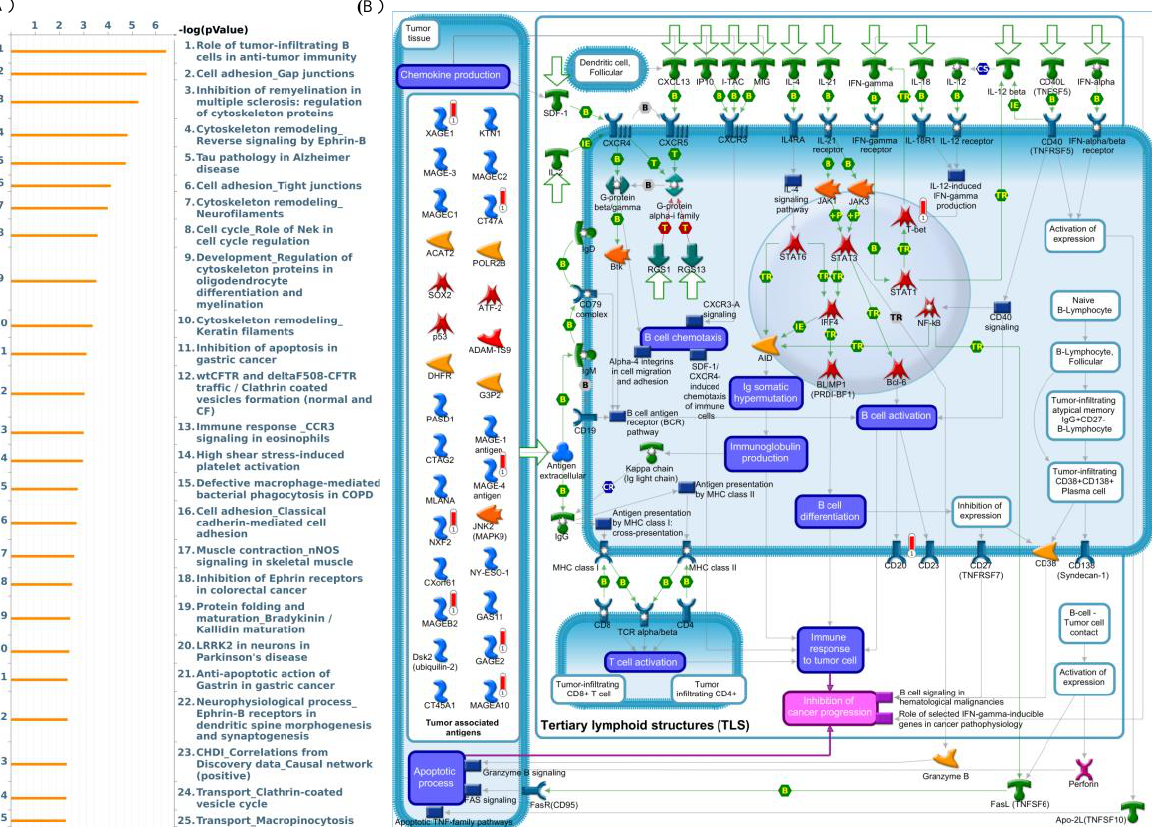
Figure 4. MetaCore enrichment pathway analysis of L-antigen 1 (LAGE1) co-expressed genes list in a breast cancer database. ( A ) In order to investigate potential gene networks and indicate pathways affected by the chosen genes, we exported LAGE1 co-expressed genes from TCGA and METABRIC breast cancer datasets to the MetaCore pathway analytical tool. ( B ) The “biology processes” analysis from MetaCore revealed that the “role of tumor-infiltrating B cells in the anti-tumor immunity-related pathway” was correlated with breast cancer